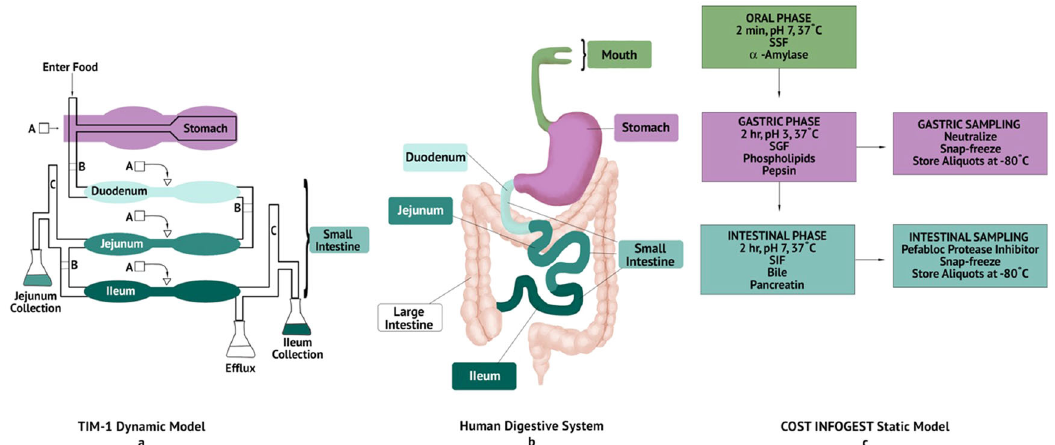
Fig. 8 Comparison of the human GI tract to the dynamic and static in vitro digestion models. a The TNO gastrointestinal model 1 (TIM-1) dynamic in vitro digestion model (TNO Triskelion, Zeist, The Netherlands) contains four major compartments: the stomach, and the duodenum, jejunum, and ileum of the small intestine. Food enters the system and is exposed to simulated digestive secretions ( a ) as it fl ows through the system. Peristaltic valves ( b ) connect the major compartments and allow for the pumping of digesta throughout the system. Digestion products in the jejunum and ileum are fi ltered by dialysis through a hollow fi ber system ( c ) for collection 60 . b A generalized overview of the human gastrointestinal tract. c Overview of the COST FA1005 Action INFOGEST standardized in vitro static digestion model. Each phase consisted of simulated digestive fl uids (simulated salivary fl uid, SSF; simulated gastric fl uid, SGF; simulated intestinal fl uid, SIF) and the major digestive enzymes at physiological activity levels 59 . Figure designed by Patty Rybolt of Patty Rybolt Designs; inspiration for panel ( a ) drawn from Minekus 60